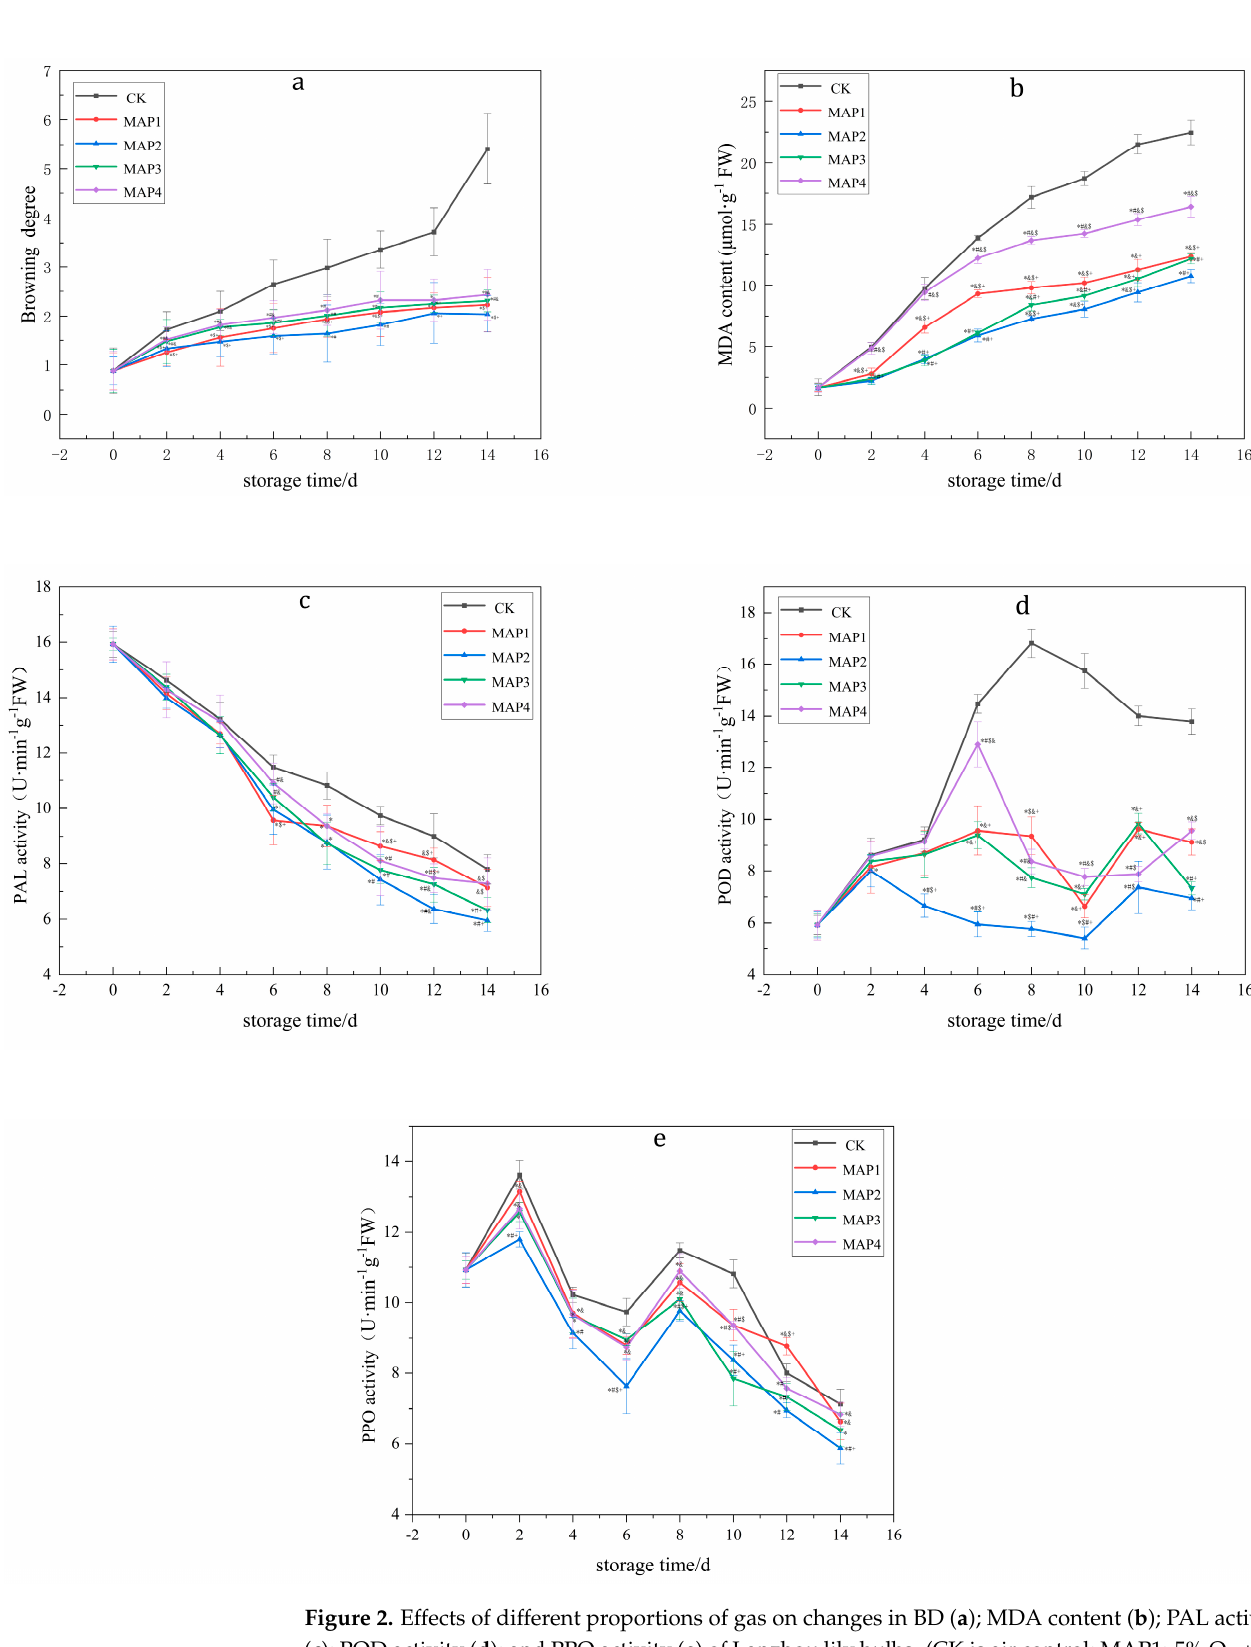
Figure 2. Effects of different proportions of gas on changes in BD ( a ); MDA content ( b ); PAL activity ( c ); POD activity ( d ); and PPO activity ( e ) of Lanzhou lily bulbs. (CK is air control; MAP1: 5% O 2 + 5% CO 2 + 90% N 2 ; MAP2: 10%O 2 + 5% CO 2 + 85% N 2 ; MAP3: 5% O 2 + 10% CO 2 + 85% N 2 ; MAP4: 10% O 2 + 10% CO 2 + 80% N 2 . *, compared to CK, p < 0.05; #, compared to MAP1, p < 0.05; &, compared to MAP2, p < 0.05; $, compared to MAP3, p < 0.05; +, compared to MAP4, p < 0.05).